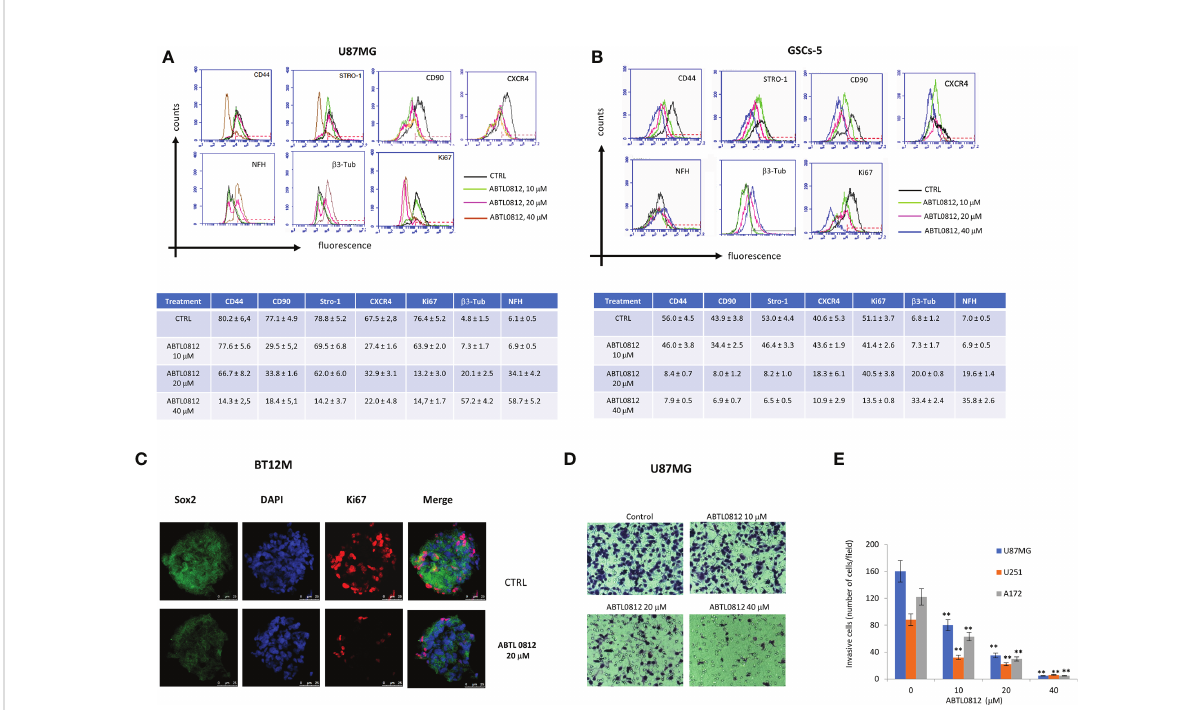
FIGURE 2 ABTL0812 induces glioblastoma and GSCs differentiation and reverts proneural to mesenchymal transition. (A) Representative FACS expression pro fi les of mesenchymal (CD44, Stro1 and CD90), stemness (CXCR4), neural ( b III tubulin, NFH and GAP43) and proliferation (Ki67) markers and table and histograms showing the percentage of cells expressing the markers analyzed by FACS in glioblastoma cells U87MG treated with ABTL0812 for 48 hours (B) and in glioblastoma stem cells GSCs-5 treated for 48 hours with ABTL0812 (C) Representative confocal images of BT12M cells stained with Sox2, b III tubulin and Ki67. Cell nuclei were stained with DAPI. (D) Representative images from Boyden chamber assays showing invasive U87MG cells after a 6-hour assay that were pretreated with ABTL0812 for 48 hours (E) Quanti fi cation of invasive cells from a matrigel invasion assays performed in U87MG, U251 and A172 cells treated with ABTL0812. CTRL= control vehicle-treated cells. ** p<0.01 vs vehicle